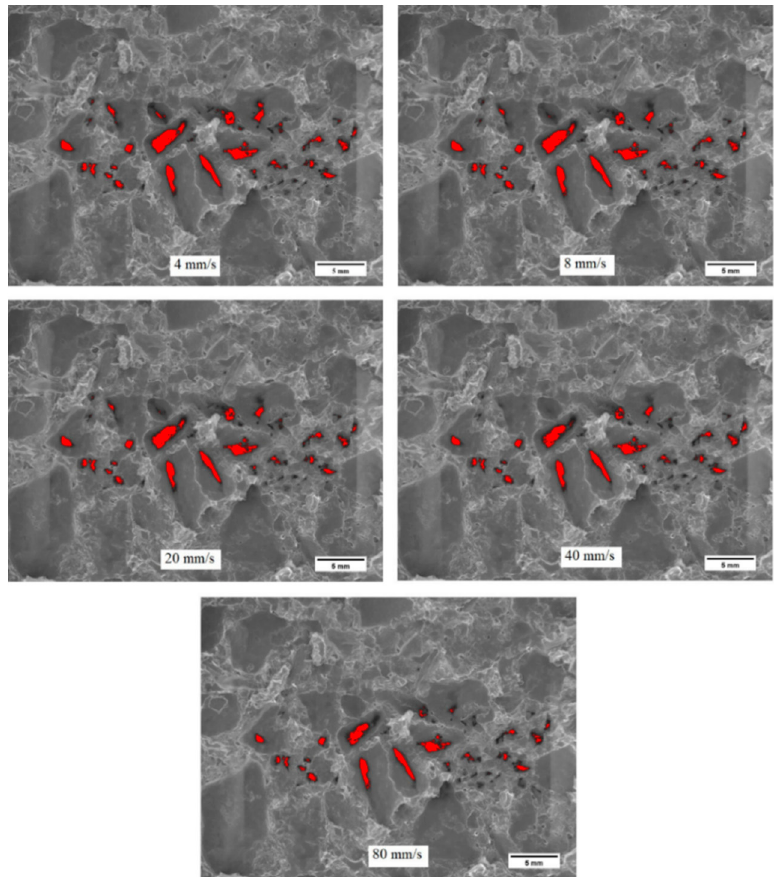
Figure 12. Images of contact area for five di ff erent moving speed at the same contact position (images belong to applied load 40.2 N).